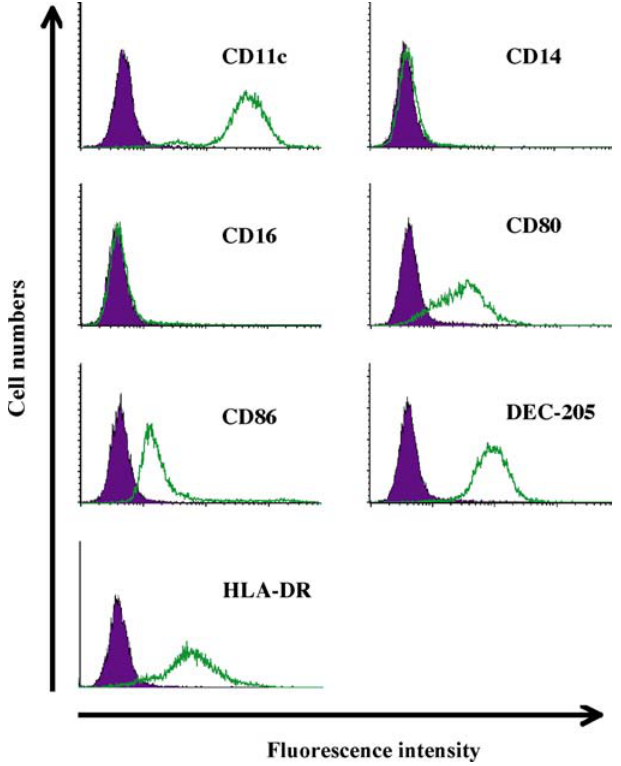
Figure 1. FACS Profile of Immature Human